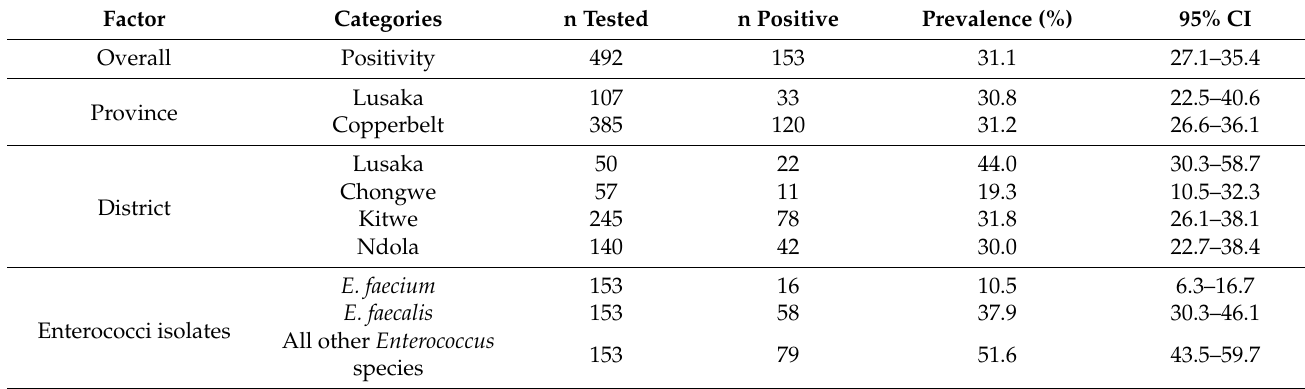
Table 2. Prevalence of Enterococcus in Poultry from the four